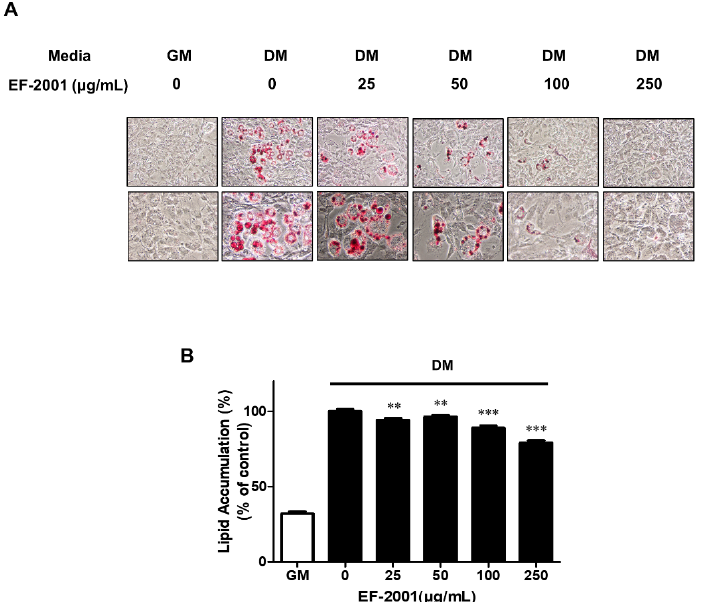
Figure 3. Effects of EF-2001 on lipid accumulation of 3T3-L1 adipocyte differentiation. ( A ) Effects of EF-2001 on differentiated 3T3-L1 adipocyte with ORO staining. 3T3-L1 preadipocytes were cultured with growth medium (GM) or differentiation medium (DM) in the absence or presence of EF-2001 (25–250 μ g/mL) for 6 days. Lipid accumulation of 3T3-L1 adipocyte was observed by ORO staining. ( B ) Effects of EF-2001 on the relative lipid accumulation of 3T3-L1 adipocyte differentiation. ORO- stained 3T3-L1 cells were eluted with 100% isopropanol, and optical density (O.D.) was measured at 490 nm. Data are represented as mean ± SEM. ( n = 4); ** p < 0.01 and *** p < 0.001 vs. control (without EF-2001 in differentiation medium).